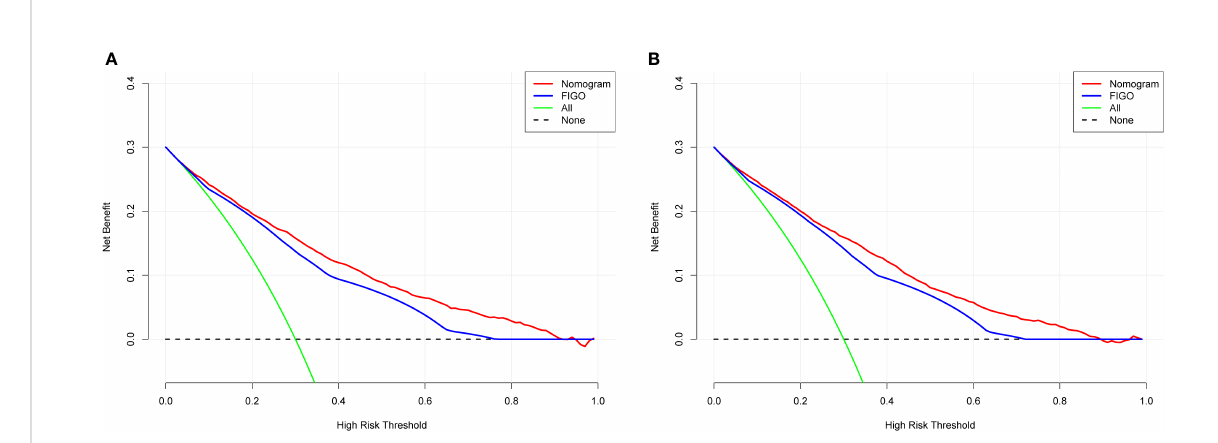
FIGURE 5 Decision curve analysis of the nomogram and FIGO stage prediction model for predicting OS (A) and CSS (B) in the training cohort. The x-axis represents the percentage of threshold probability, whereas the y-axis represents the net bene fi t, calculated by adding the true positives and subtracting the false